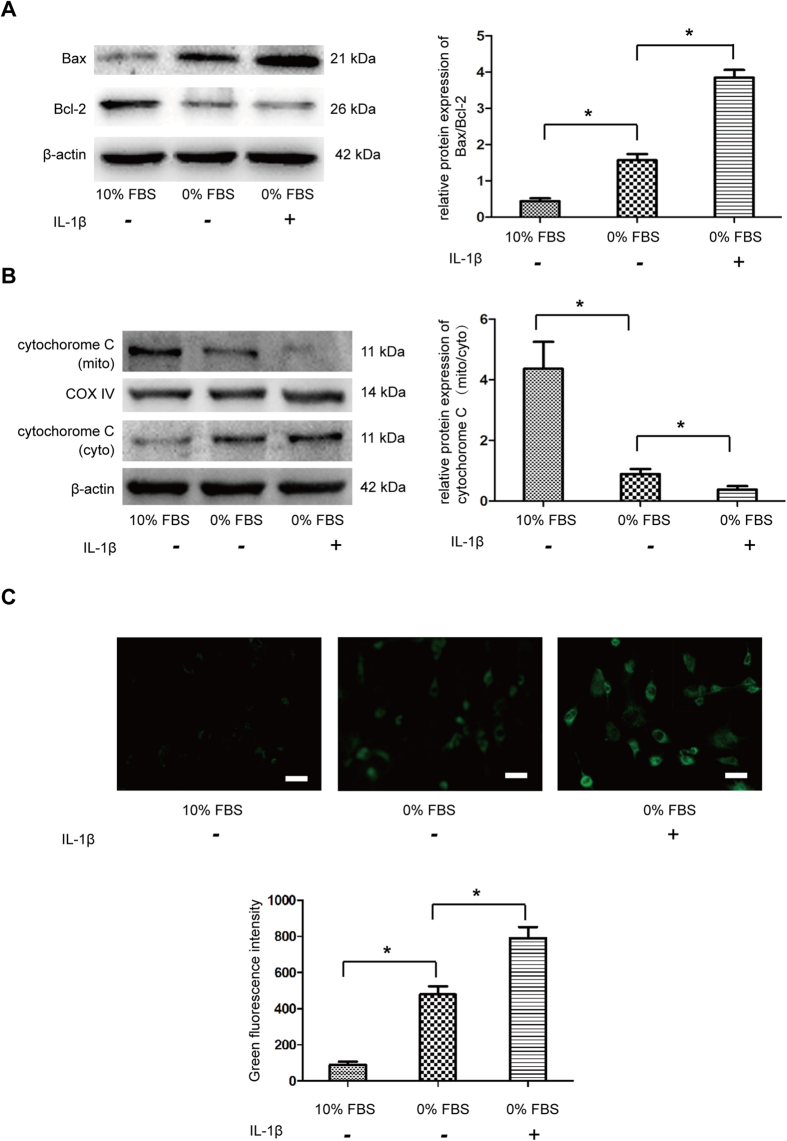
Effect of IL-1β on apoptosis mediated through the mitochodrial pathway in NP cells.(A) Western blot analysis for the protein expression of Bax, Bcl-2. The ratio of Bax/Bcl-2 was quantified. (B) Western blot analysis for the protein expression of cytochrome c from mitochondria and cytoplasm, respectively. The ratio of cytochrome c (mito)/cytochrome c (cyto) was quantified. (C) The intracellular ROS levels were measured by flow cytometry through DCFH-DA staining. The mean fluorescence intensity (MFI) of 10,000 cells was recorded. *P < 0.05 Vs. 0% FBS group.